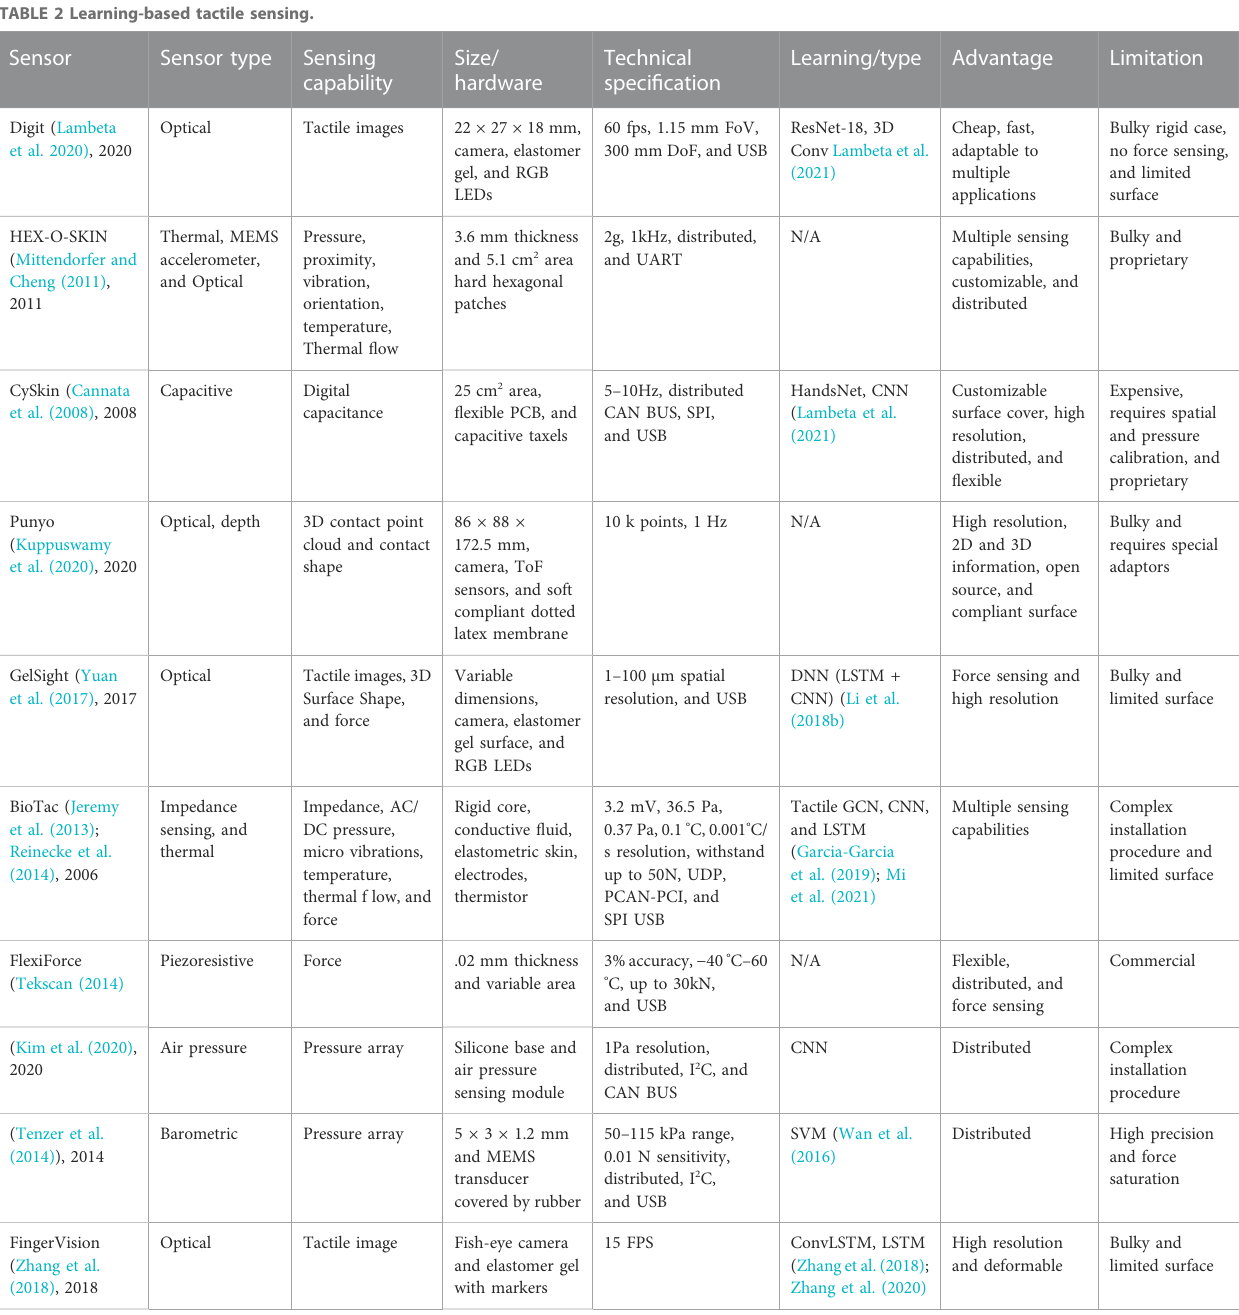
TABLE 2 Learning-based tactile